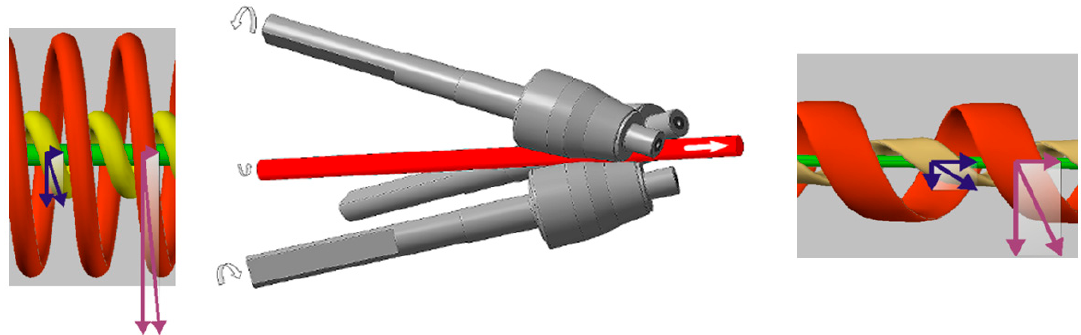
Figure 1. Scheme of radial-shear rolling and features of the metal flow of the axial, intermediate and peripheral zones of the workpiece.